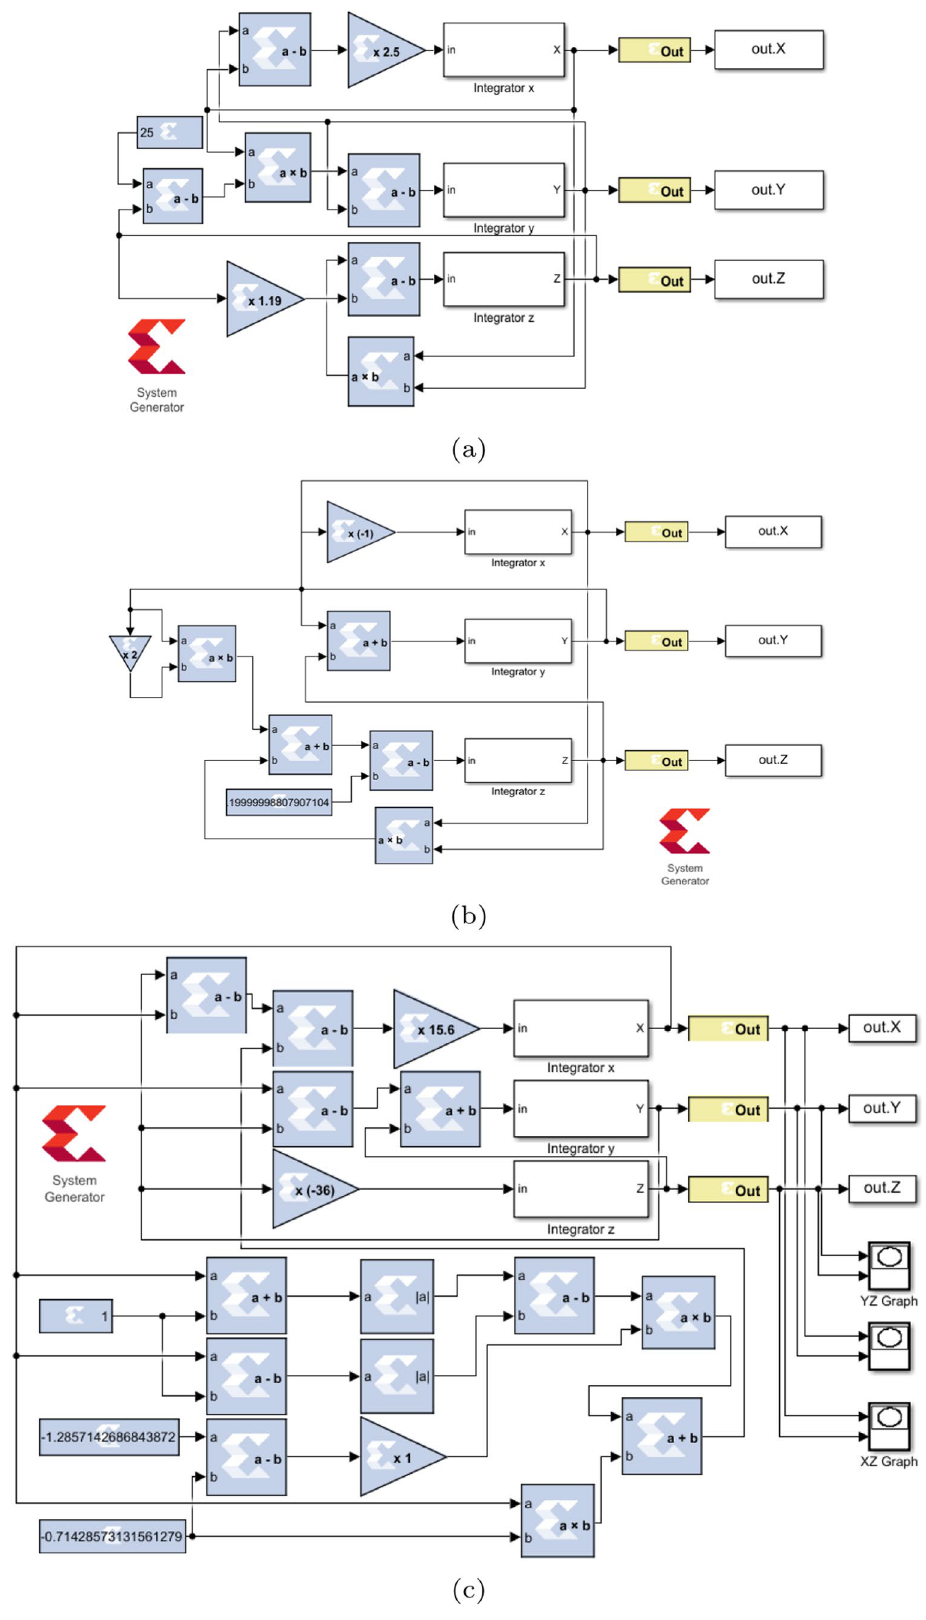
Fig. 11 XSG design for trans- mitter of a Lorenz, b SprottD, and c